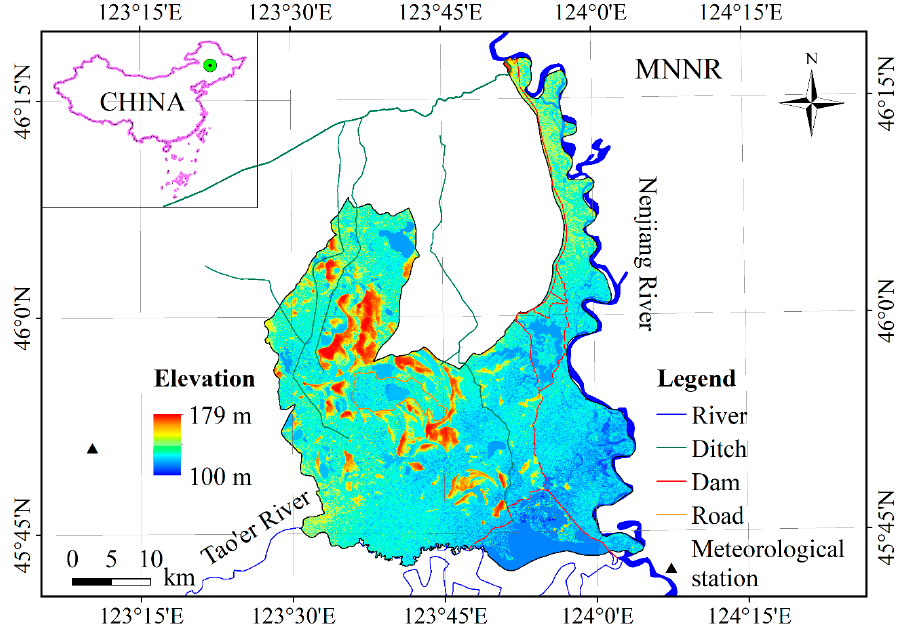
Figure 1. Location, elevation as well as the river, ditch, dam, road and meteorological station of the China’s Momoge National Nature Reserve (MNNR). Data source: NASA Earth data.